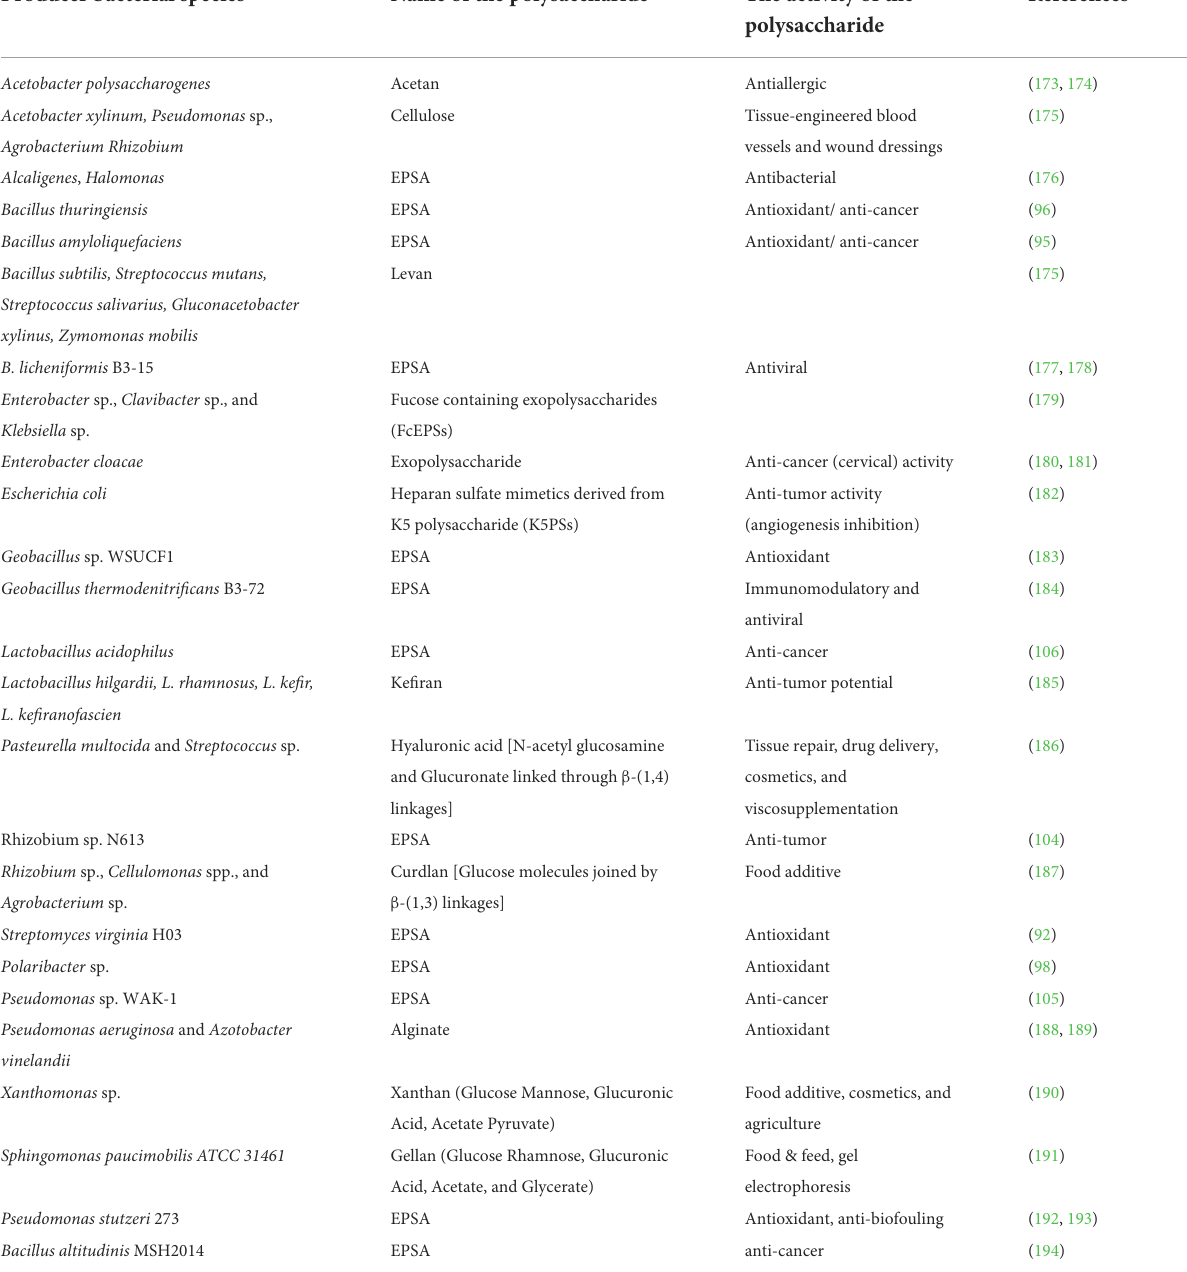
TABLE 1 Sources, type, and potential properties/applications of some well-known bacterial